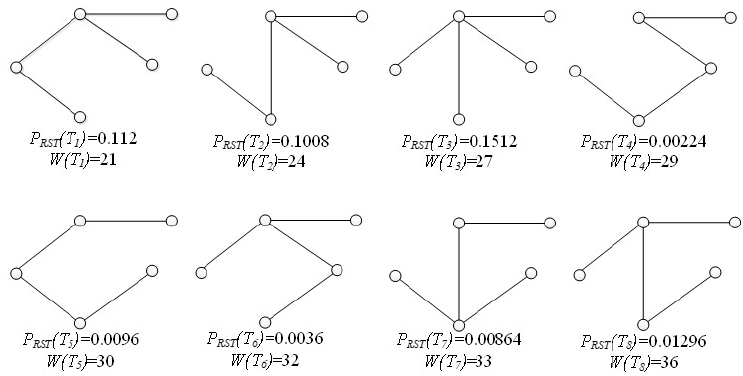
Figure 3. The possible RSTs of G 1